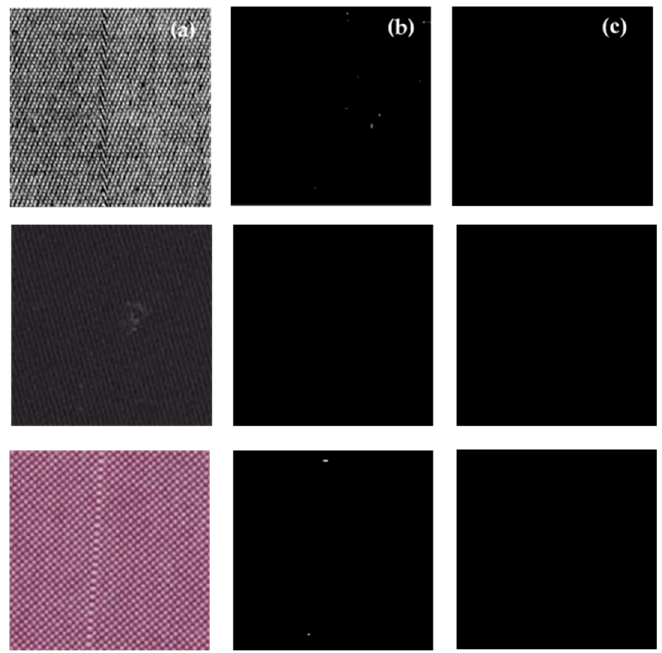
Figure 1. Failure of the BB and ID methods for detecting defects. ( a ) Defect sample, ( b ) detection result using the BB method, and ( c ) detection result using the ID method.